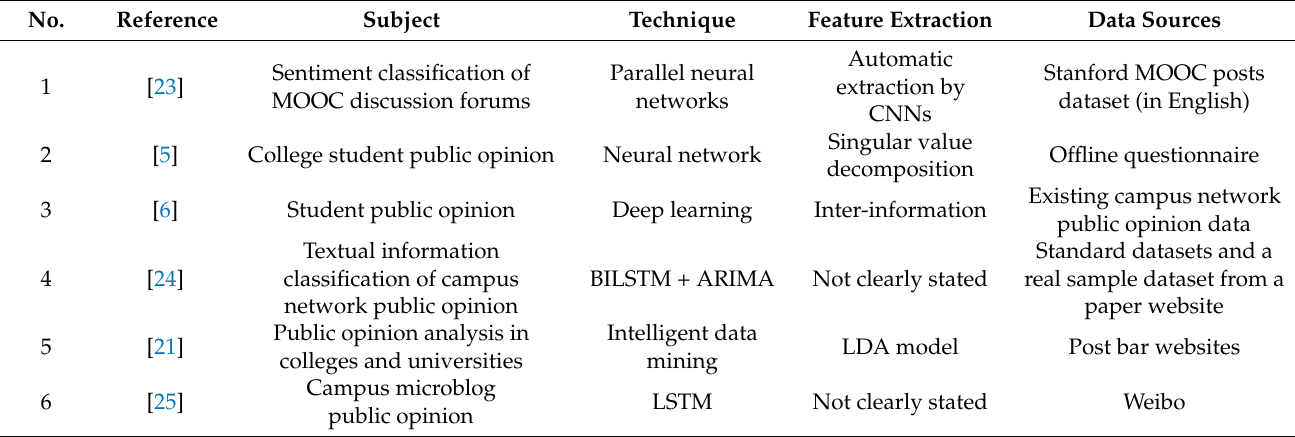
Table 1. Summary of articles regarding deep learning and other models for sentimental analysis in the educational